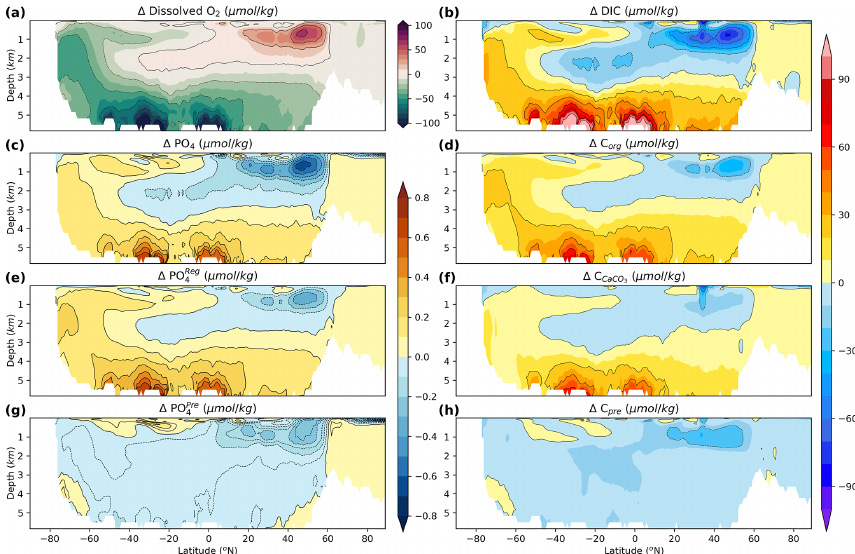
Figure 4. Global marine carbon budget and decomposition. Global zonal and annual mean anomalies of (a) dissolved oxygen concentra- tion (µmolkg − 1 ), (c) phosphate concentration (µmolkg − 1 ), (e) regenerated phosphate concentration (µmolkg − 1 ), (g) preformed phosphate concentration (µmolkg − 1 ), (b) total DIC (µmolkg − 1 ), (d) remineralized carbon (µmolkg − 1 ), (f) dissolved carbonate (µmolkg − 1 ), and (h) preformed DIC (µmolkg − 1 ) are given in the individual panels. Note that the phosphate components (c, e, g) and the DIC components (b, d, f, h) each share common colour